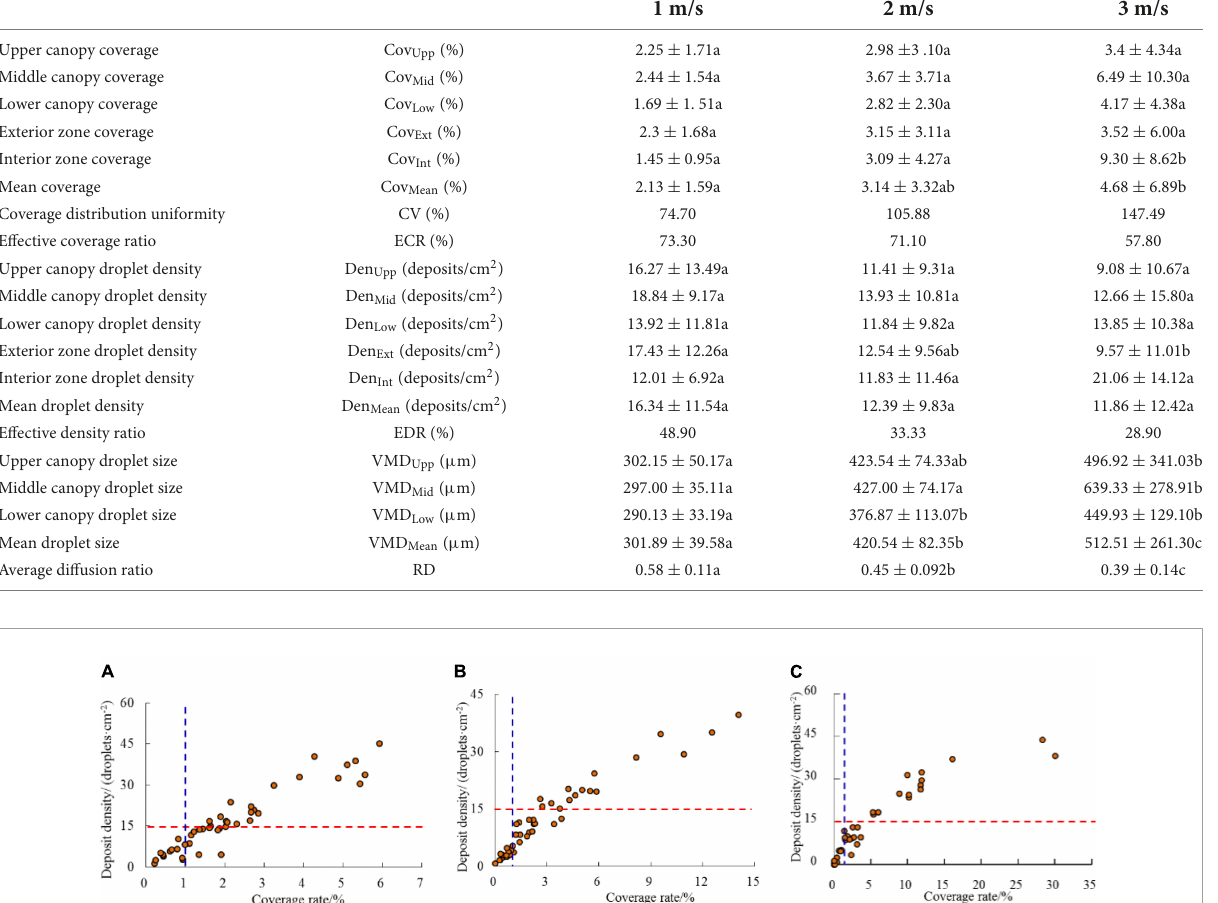
FIGURE6 Plots of deposit density and spray coverage rate for different flight velocities. The horizontal red dashed line and the vertical blue dashed line represent the minimum droplet density (15 deposits/cm 2 , Song et al., 2017) and coverage (1%, Chen et al., 2022) required for plant protection UAV application, respectively. (A) 1 m/s. (B) 2 m/s. (C) 3